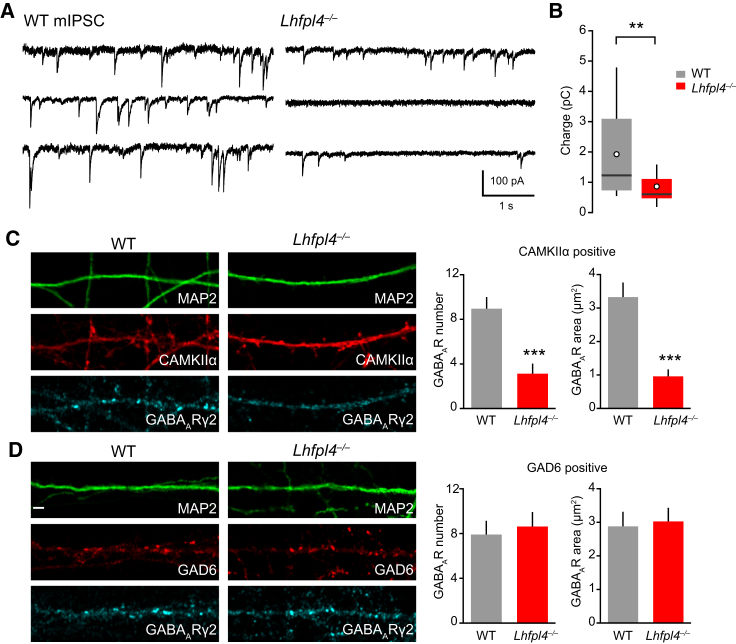
Selective Loss of mIPSCs in Cultured Lhfpl4−/− Neurons(A) Representative recordings of mIPSCs (−70 mV) in cultured hippocampal neurons prepared from WT mice (left) and Lhfpl4−/− mice (right). In each case, recordings from three different neurons are shown. Records digitally filtered at 2 kHz for illustration purposes.(B) Pooled data showing reduction in mean mIPSC charge transfer (from 1.93 pC ± 0.37 pC to 0.86 pC ± 0.12 pC; n = 18 WT and 24 Lhfpl4−/− cells; p = 0.0058, Wilcoxon rank-sum test). Box-and-whisker plots indicate median (line), 25th–75th percentiles (box), the range of data within 1.5 × interquartile range (IQR) of box (whiskers), and mean (open circles).(C and D) Confocal images and cluster quantification of dissociated DIV14 WT or Lhfpl4−/− hippocampal neurons transfected with GFP and labeled with antibodies to GABAAR-γ2 and either (C) CAMKIIα or (D) GAD6 to label excitatory neurons and inhibitory neurons, respectively. GABAAR cluster number and area were significantly reduced in Lhfpl4−/− CAMKIIα-positive cells (cluster number: from 8.9 ± 1.0 to 3.1 ± 0.9; area: from 3.3 μm2 ± 0.4 μm2 to 1.0 μm2 ± 0.2 μm2; 362/131 WT/Lhfpl4−/− clusters; p = 0.00032 and 0.00013, respectively), but not GAD6-positive cells, compared to WT (cluster number: from 7.9 ± 1.2 to 8.6 ± 1.3; area: from 2.9 μm2 ± 0.4 μm2 to 3.0 μm2 ± 0.4 μm2; 376/362 WT/Lhfpl4−/− clusters; p = 0.69 and 0.81, respectively). Error bars indicate mean ± SEM. For all conditions, n = 14 cells from 3 independent preparations. All used the Welch t test. ∗∗p < 0.01, ∗∗∗p < 0.001. Scale, 2 μm.